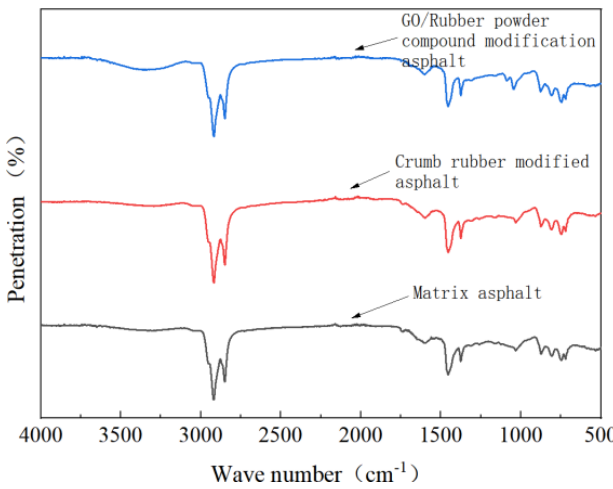
Figure 11. Infrared spectra of three kinds of modified asphalt.